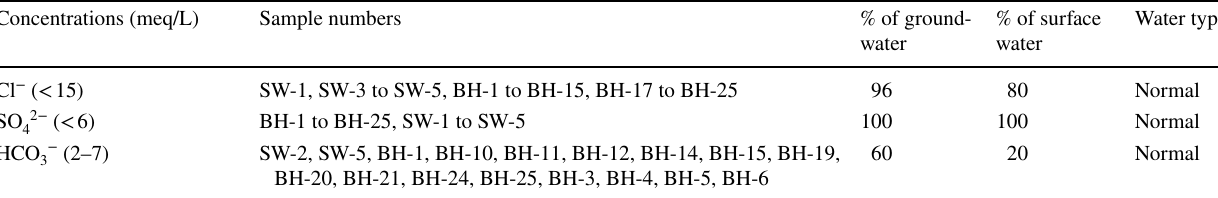
Table 6 Groundwater and surface water classification according to Cl − , SO 42− and HCO 3− Concentrations (meq/L)